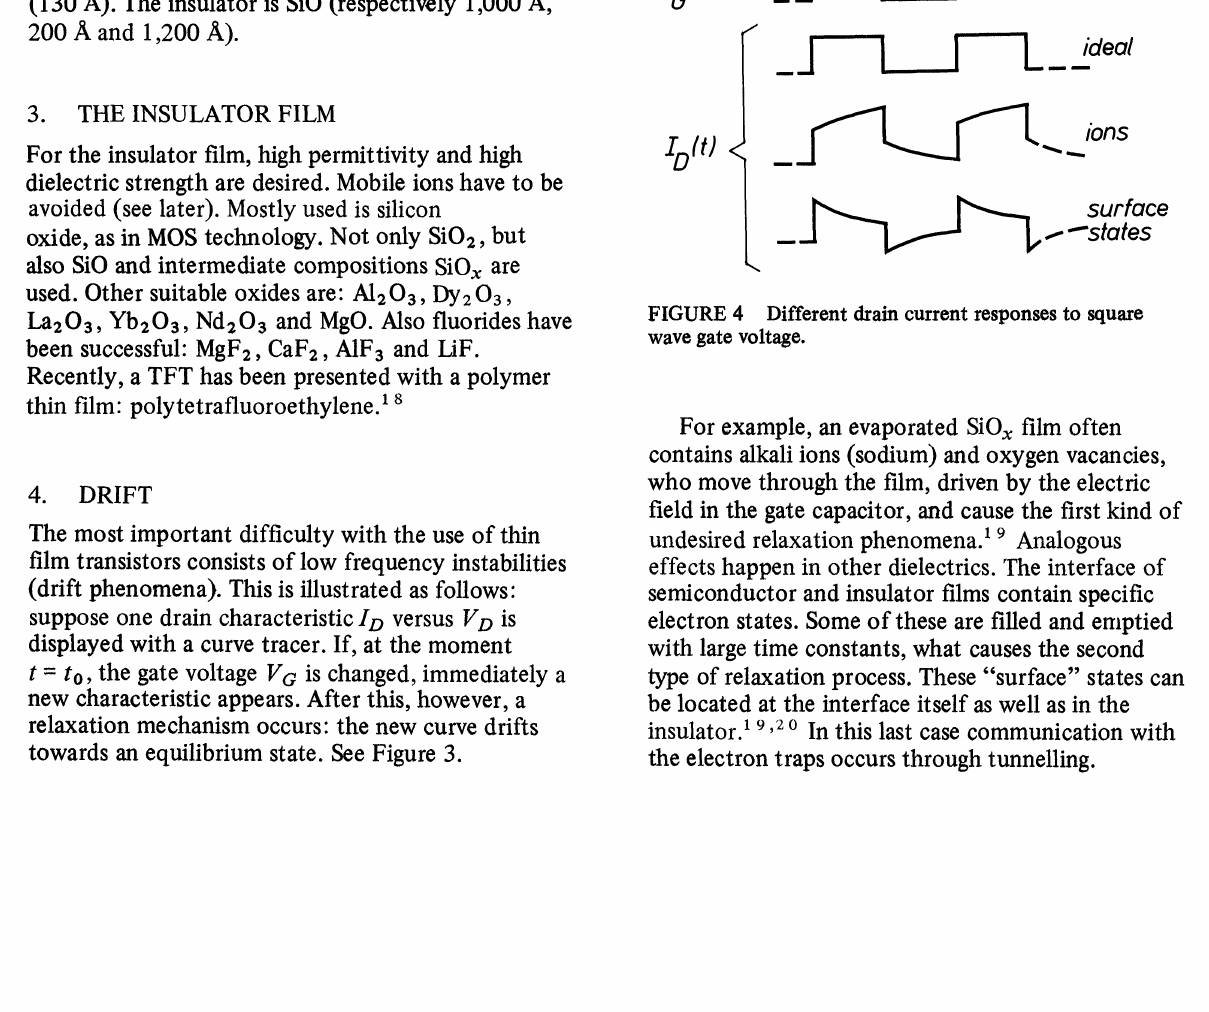
TFT characteristics for different semiconduc- tors Horizontal scale: 2 V/div Vertical scale: 0.2 mA/div.